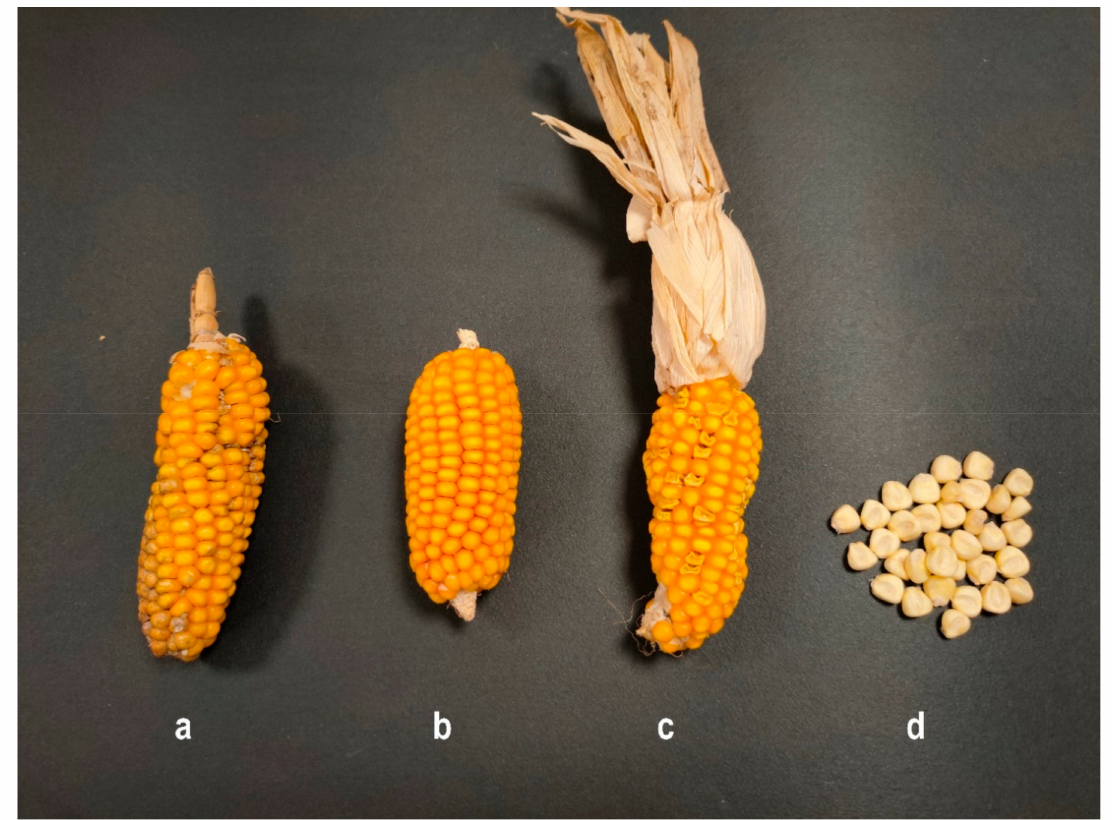
Figure 2. Maize landrace ears and seeds collected in 2021 from the AUA mission in Arcadia. ( a ) “Arapositi” collected in Leontari village, ( b ) ”Arapositi xeriko” collected in Perdikoneri, ( c ) “Arapositi” collected in Karkalou, ( d ) “Arapositi lefko” or “Kalaboki lefko” seeds collected in